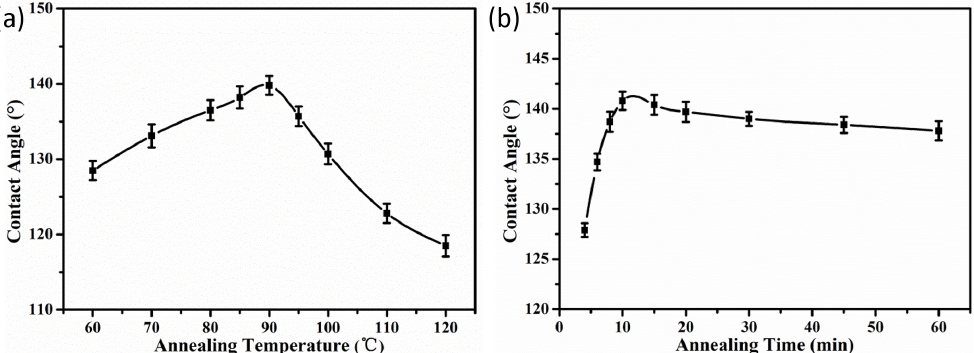
Figure 7. Effects of heat treatment on hydrophobic properties of coatings fabricated with PS/P(OFMA-S) composite particles: ( a ) at different annealing temperatures for 15 min, ( b ) with different annealing time at 90 °C.